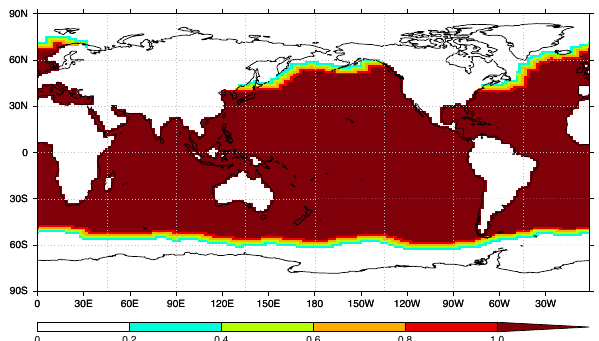
Figure 2. Coupling mask showing the five-grid-point linear blend between the MetUM-GOML coupling region ( α = 1; dark red) and the SST boundary condition outside the coupling region ( α = 0;